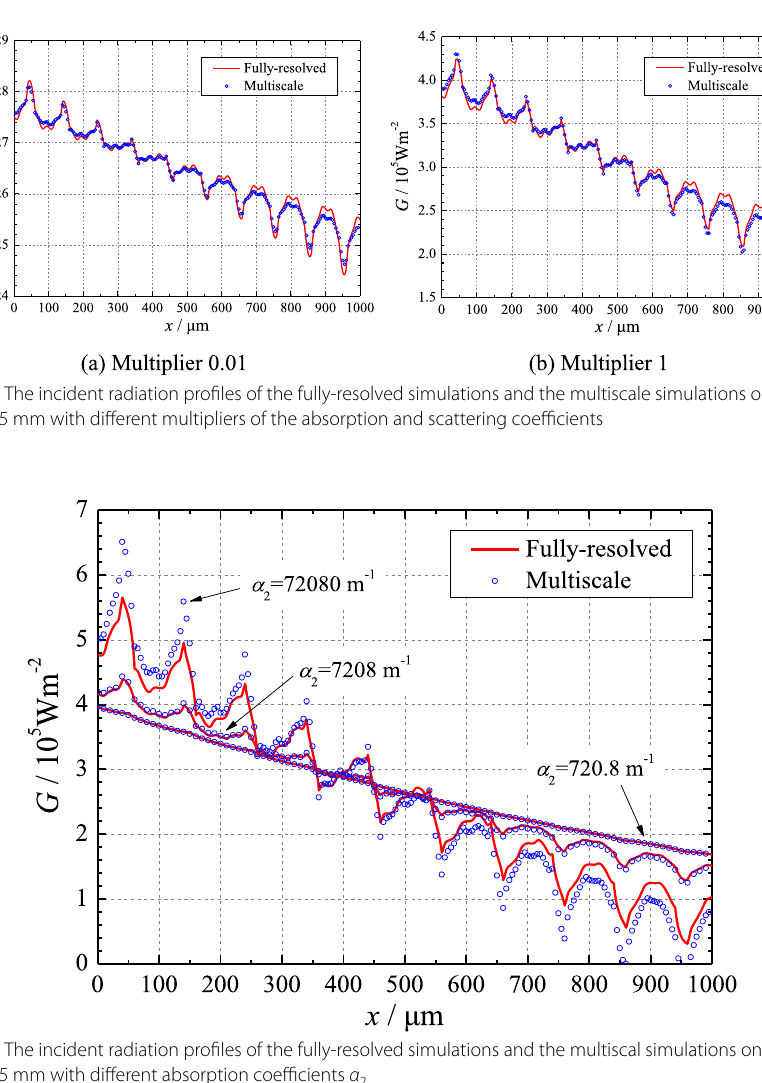
fluctuations due to the particles, but the magnitudes of the fluctuations and variations of the radiation are different. When the coefficients are small, the interaction between heat and radiation transfer is weak. The fluctuations and variations of the radiation are small